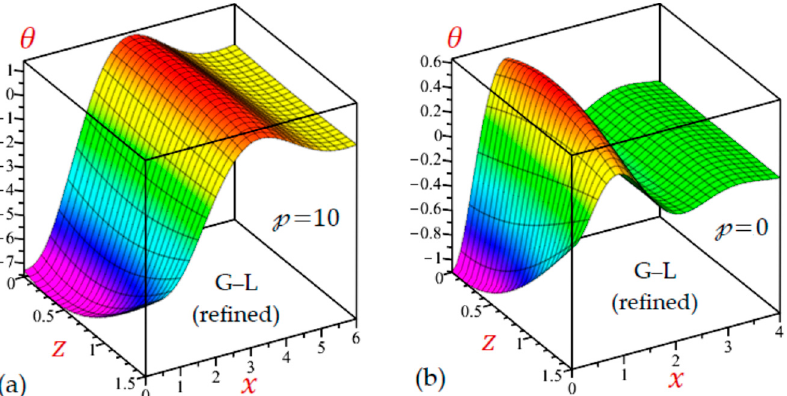
Figure 15. 3D distributions of the temperature θ of the rotating half-space: ( a ) with initial pressure